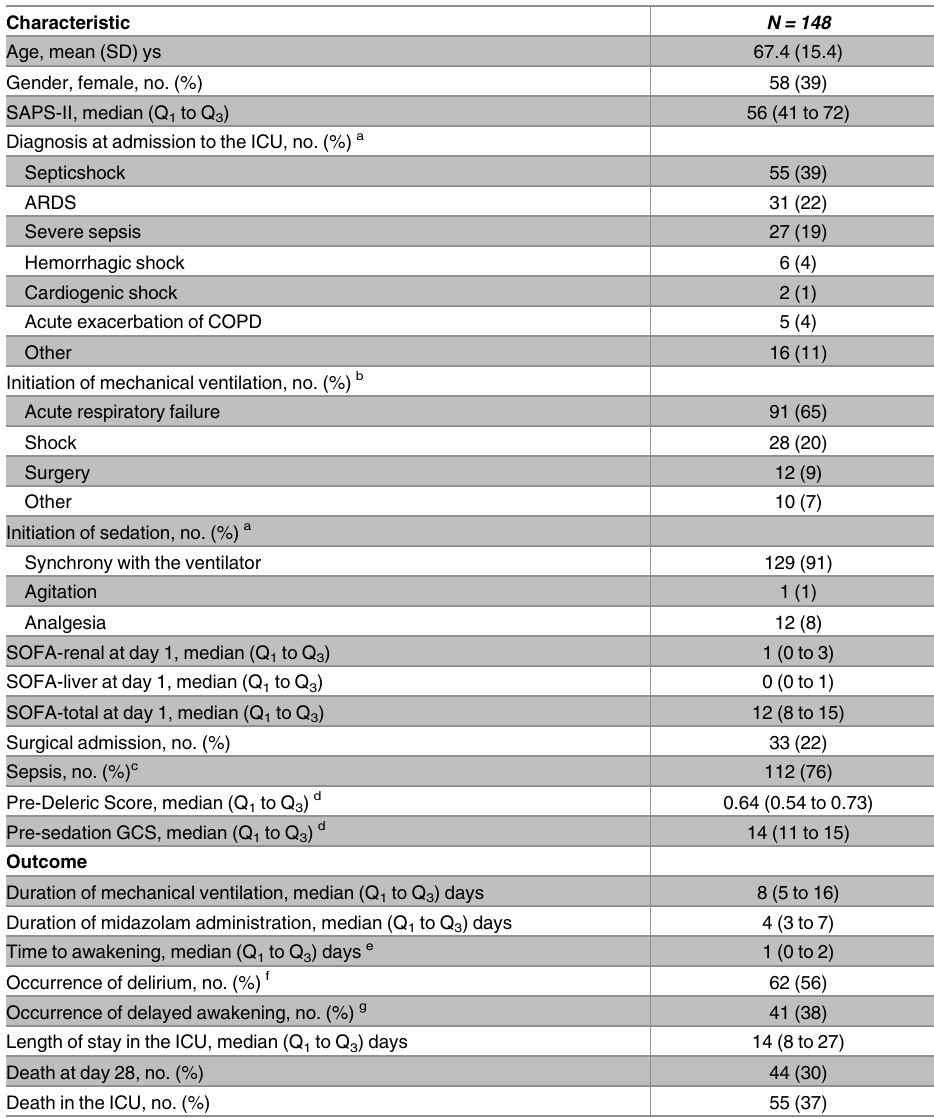
Table 1. Patient